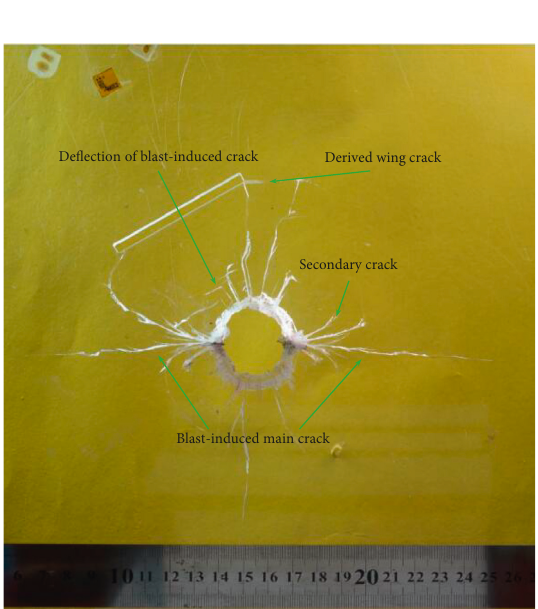
Figure 21: Blasting effect drawing for case SN